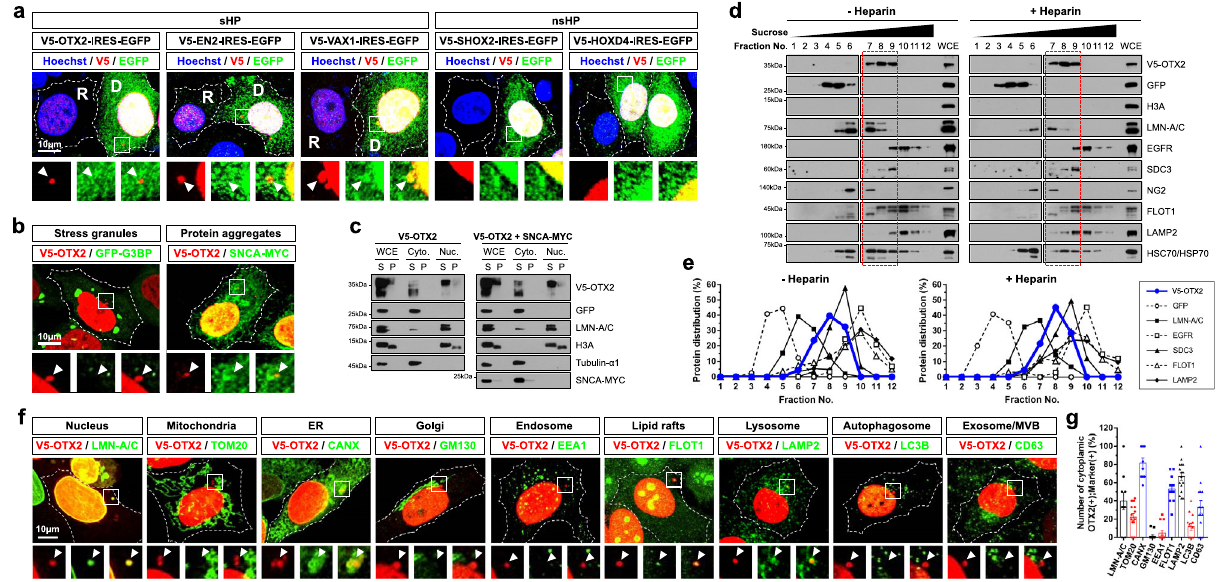
Fig. 1 | Cytoplasmic OTX2 is located in the membrane fraction. a V5-tagged humanHPs,OTX2,EN2,VAX1,SHOX2,orHOXD4,overexpressedinHeLacellswere detected by immunostaining with anti-V5 antibody. GFP, which was expressed in the same transcripts with these HPs, was also co-stained with anti-GFP antibody. Nuclei of the cells were visualized by staining with Hoechst-33332 dye (Hoechst). These HPs were secreted from the GFP-positive donor (D) cells and transferred to therecipient(R)cells,whichexhibitHPswithoutGFP.Dottedlinesaretheedgesof thecells.Imagesinthebottomrowaremagni fi edversionsoftheboxedareasinthe top row. Arrowheads point perinuclear and cytoplasmic HP puncta. Similar observationsweremadein3independentexperiments, andrepresentativeimages are shown. b V5-OTX2 and GFP-G3BP or SNCA-MYC overexpressed in HeLa cells were visualized by immunostaining with anti-V5 and anti-GFP or anti-MYC anti- bodies. Dense signals of GFP-G3BP and SNCA-MYC in the cytoplasm are stress granules and protein aggregates, respectively. Arrowheads indicate perinuclear and cytoplasmic V5-OTX2 puncta. Similar observations were made in 3 indepen- dentexperiments,andrepresentativeimagesareshown. c Cytoplasmic(Cyto.)and nuclear (Nuc.) fractions of HeLa cells that overexpress GFP and V5-OTX2 with or without SNCA-MYC were separate as described in the Methods. The resultant fractionswereincubatedinRIPAbuffer(PBSwith0.1%( fi nal)SDS)toisolatesoluble